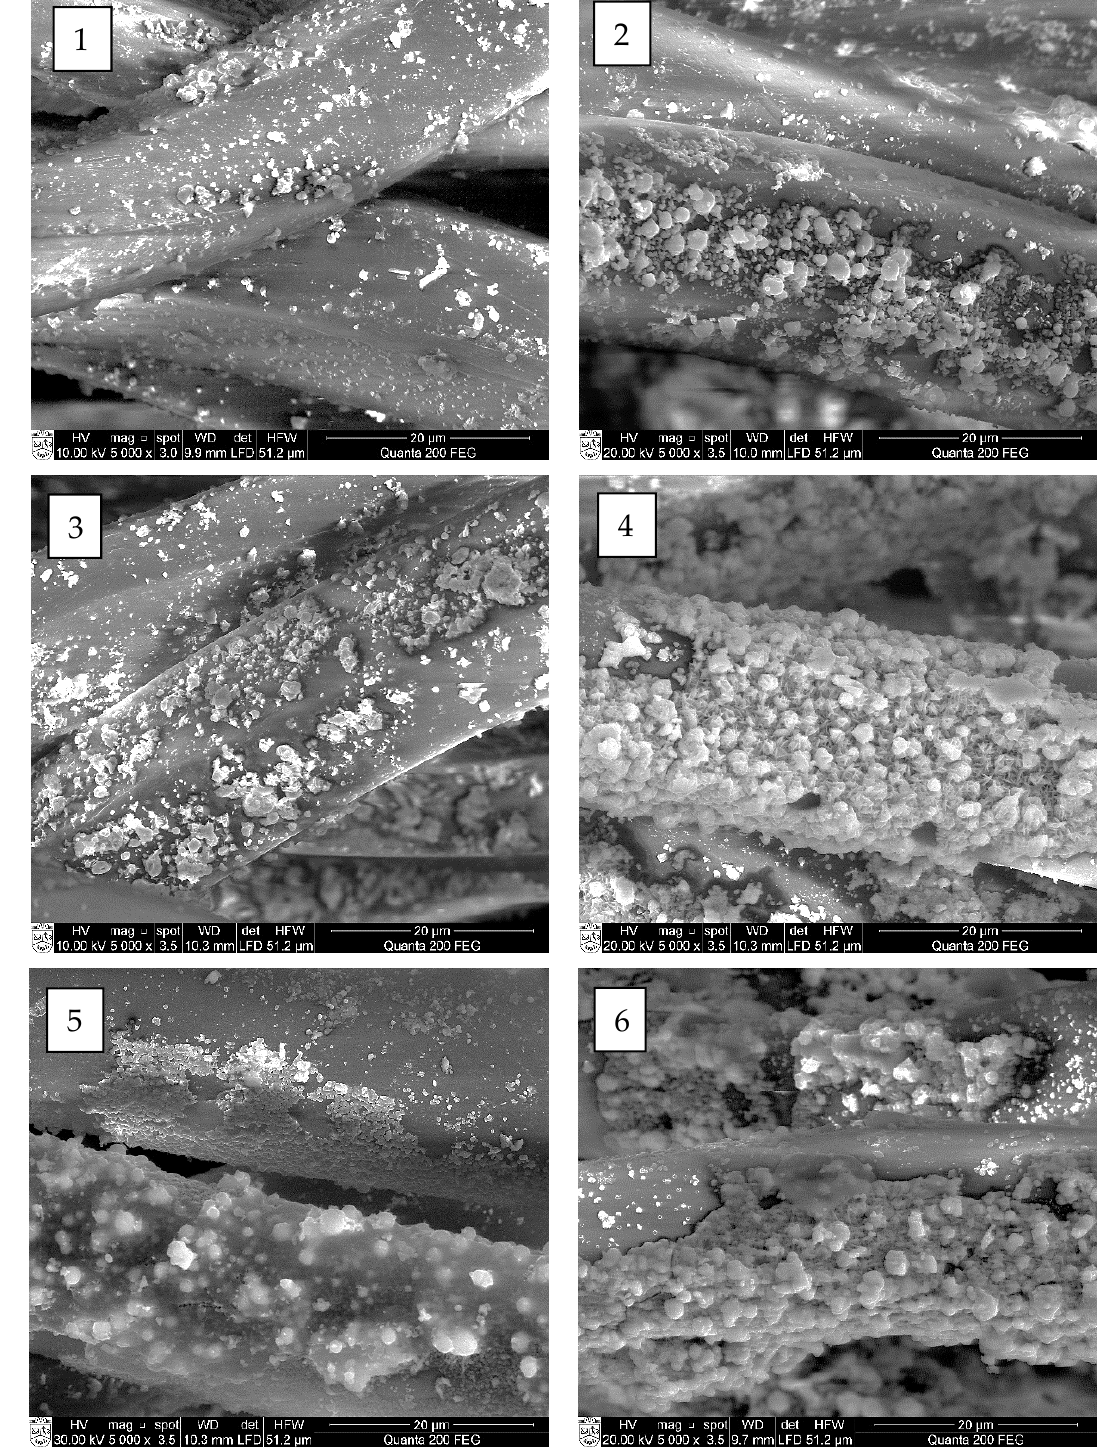
Figure 10. SEM images of copper selenide-coated PES fibers after different numbers of treatment cycles: ( 1 ) first (mag. 5000×); ( 2 ) second (mag. 5000×); ( 3 ) third (mag. 5000×); ( 4 ) fourth (mag. 5000×); ( 5 ) fifth (mag. 5000×); and ( 6 ) sixth (mag. 5000×).